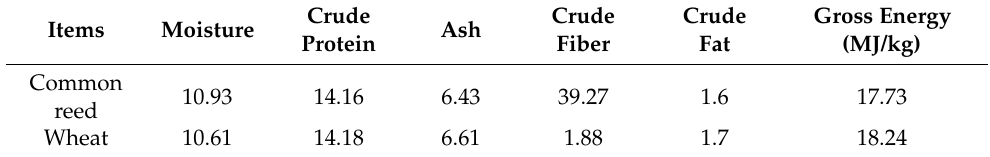
Table 1. Main active ingredients of common reed and wheat medium residue (air-dry basis%).